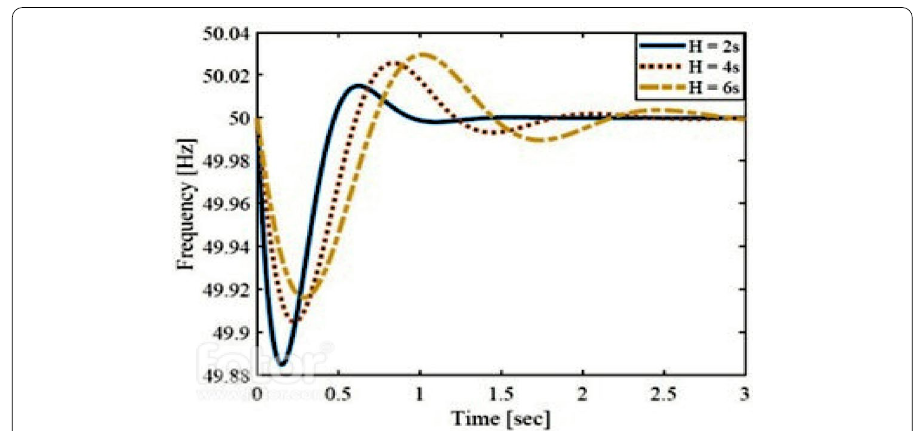
Fig. 3 Effect of system inertia on RoCoF